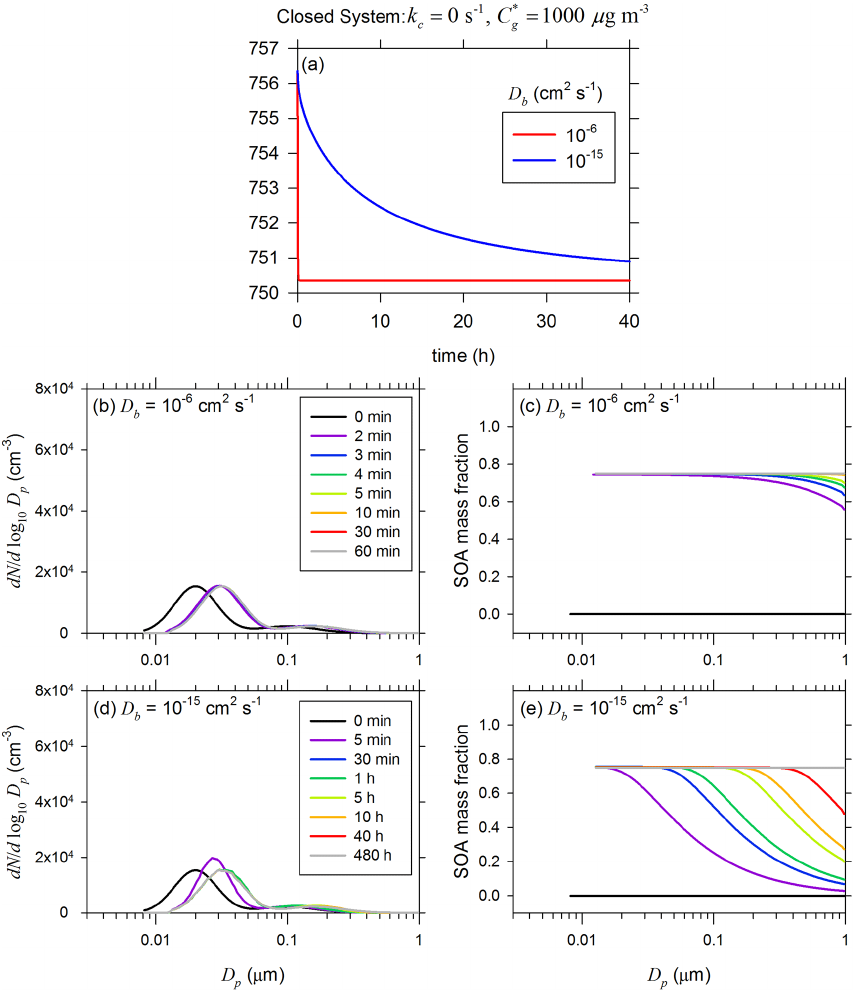
Figure 14. Same as Fig. 13, except C ∗ g = 1000µgm − 3